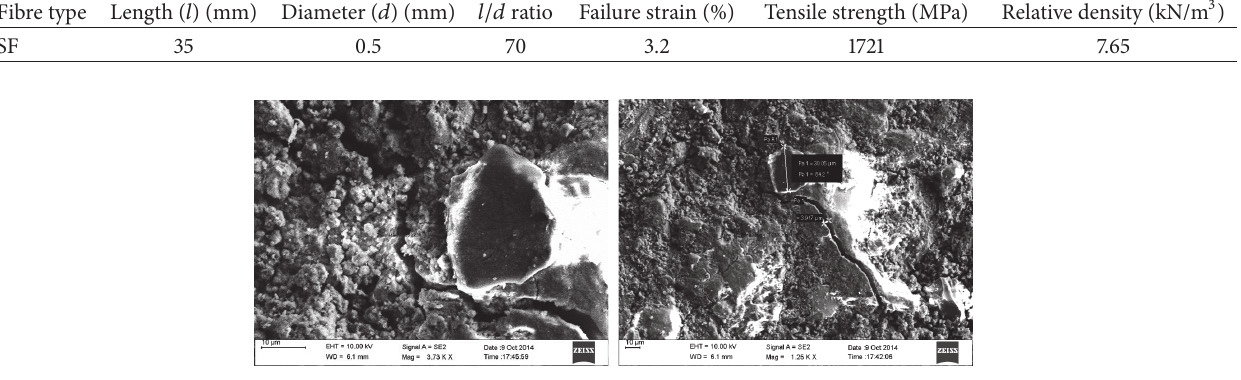
Figure 1: Scanning electron microscope image of slag in 10 𝜇 m magnification.